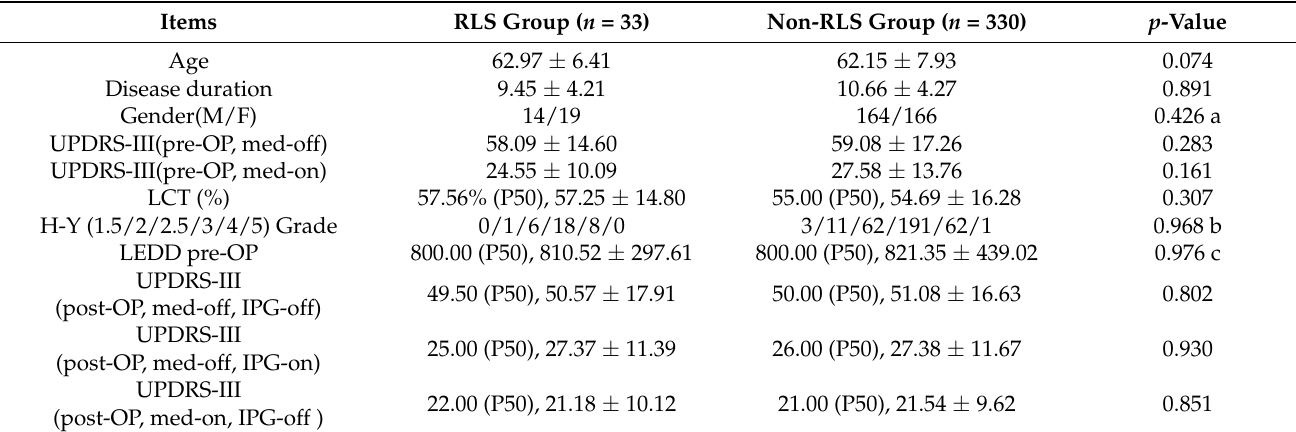
Table 1. Demographic characteristics of RLS and Non-RLS